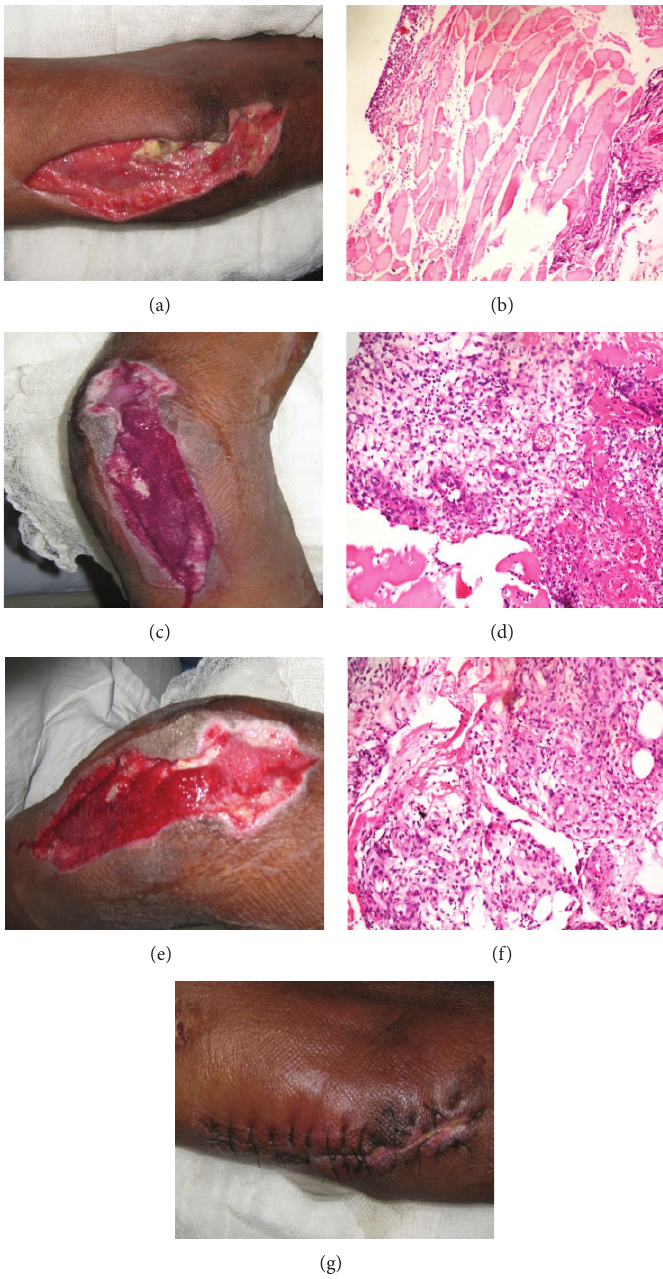
Figure6:(a)Day0:woundsize,146 × 61mm.(b)Day0:photomicrographnumber1-HandEstainedsection(100x)shows:thickneutrophillic exhudate on the surface and skeletal muscle bundles. (c) Day 4: wound size, 141 × 51mm. (d) Day 4: photomicrograph number 2-H and E stained section (100x) shows: Inflammed granulation tissue with little exhudate on the surface. (e) Day 8: Wound size, 135 × 51mm. (f) Day 8: photomicrograph number 3-H and E stained section (100x) shows: healthy granulation tissue without any exhudate. (g) Secondary closure